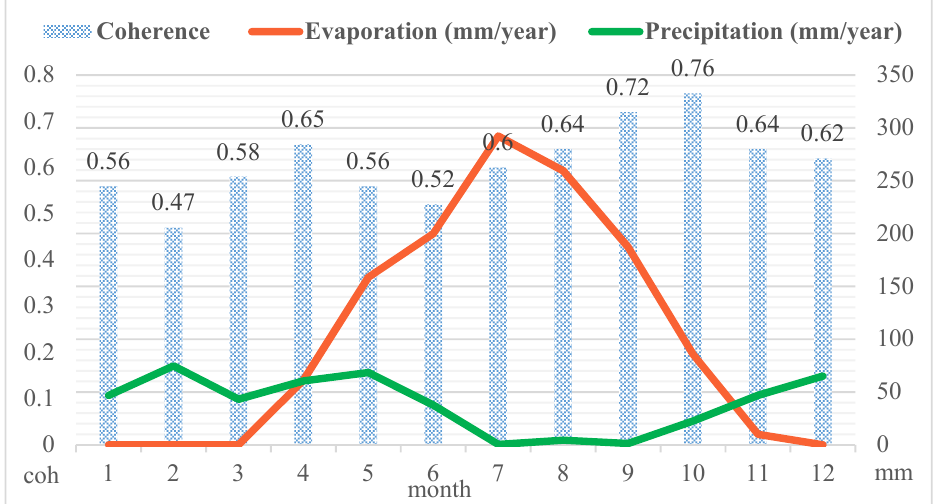
Figure 9. Average monthly precipitation, evapotranspiration and coherence. Meteorological data were obtained by mean value of Kulu, Cihanbeyli, Eskil and S. Kochisar stations around the lake.